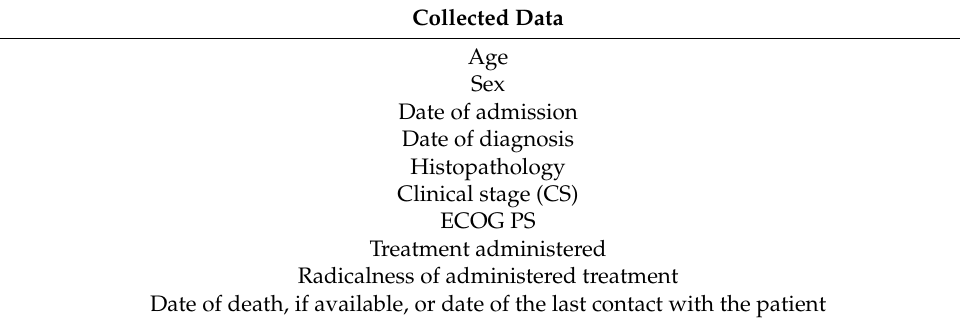
Table 1. Data collected via retrospective